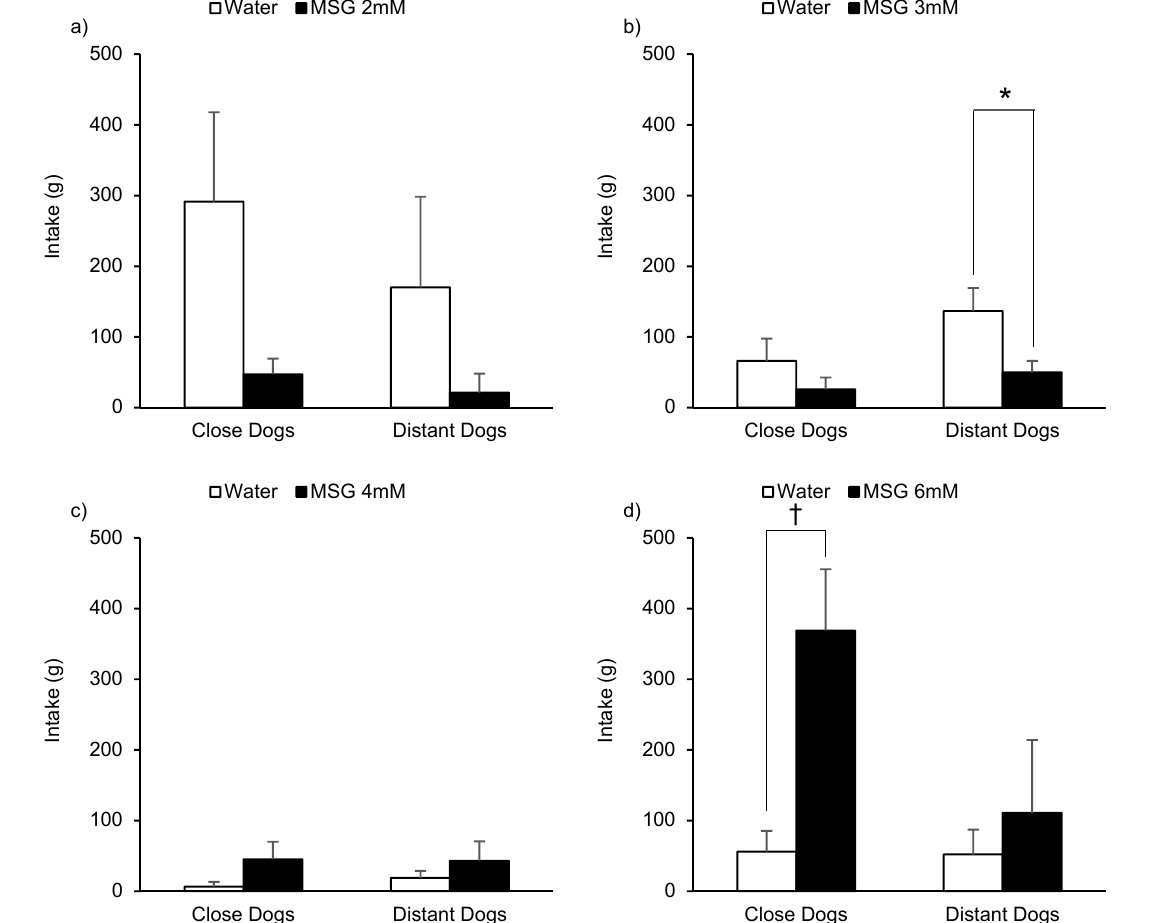
Figure 4. Consumption (least square means + standard error) of kennelled dogs in front of 2 mM ( a ), 3 mM ( b ), 4 mM ( c ), and 6 mM ( d ) monosodium glutamate (MSG) and water solutions during a 20 min preference test according to the human-approach test results (close or distant) previously assigned (* p < 0.05; † p < 0.1).